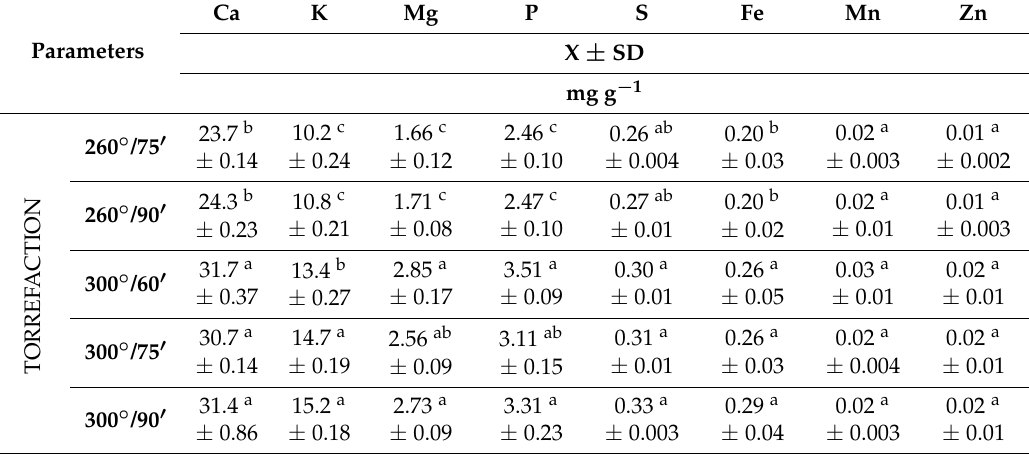
x—Average. SD—Standard deviation. Differences between average values marked with the same